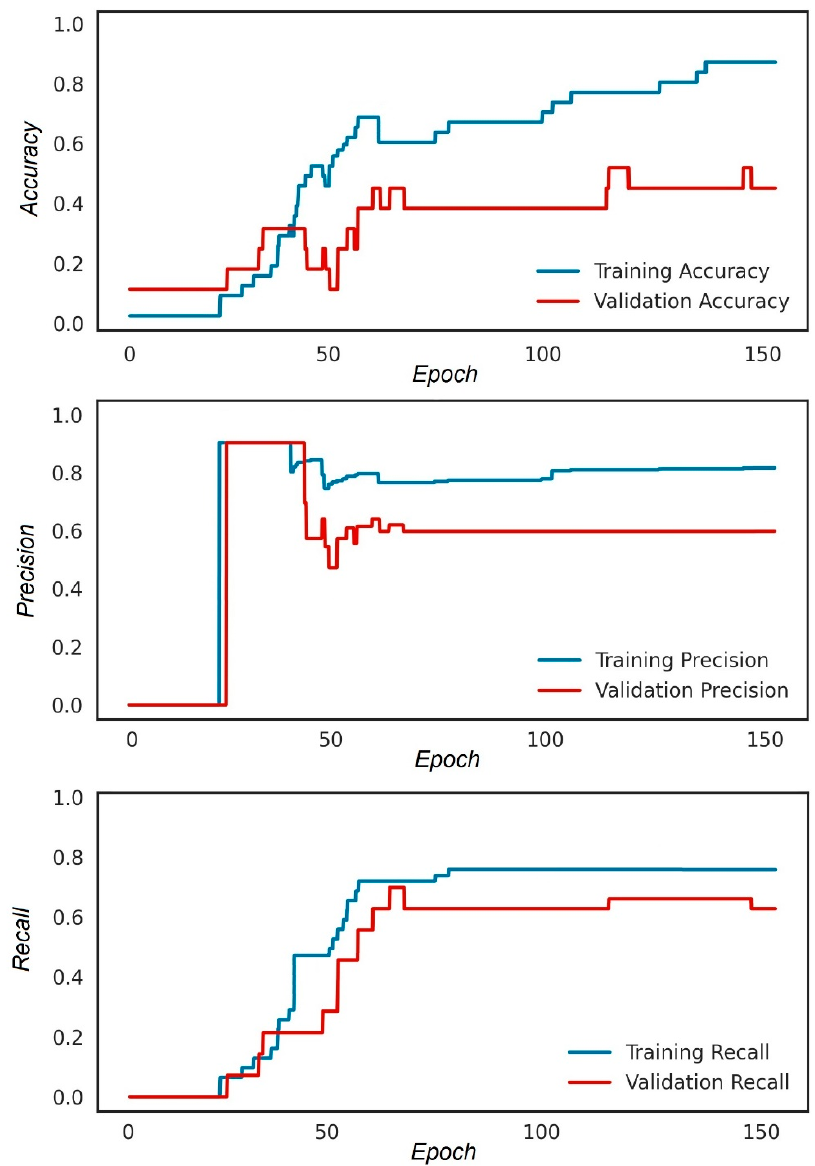
Figure 9. The evaluation criteria estimated for SVM model.